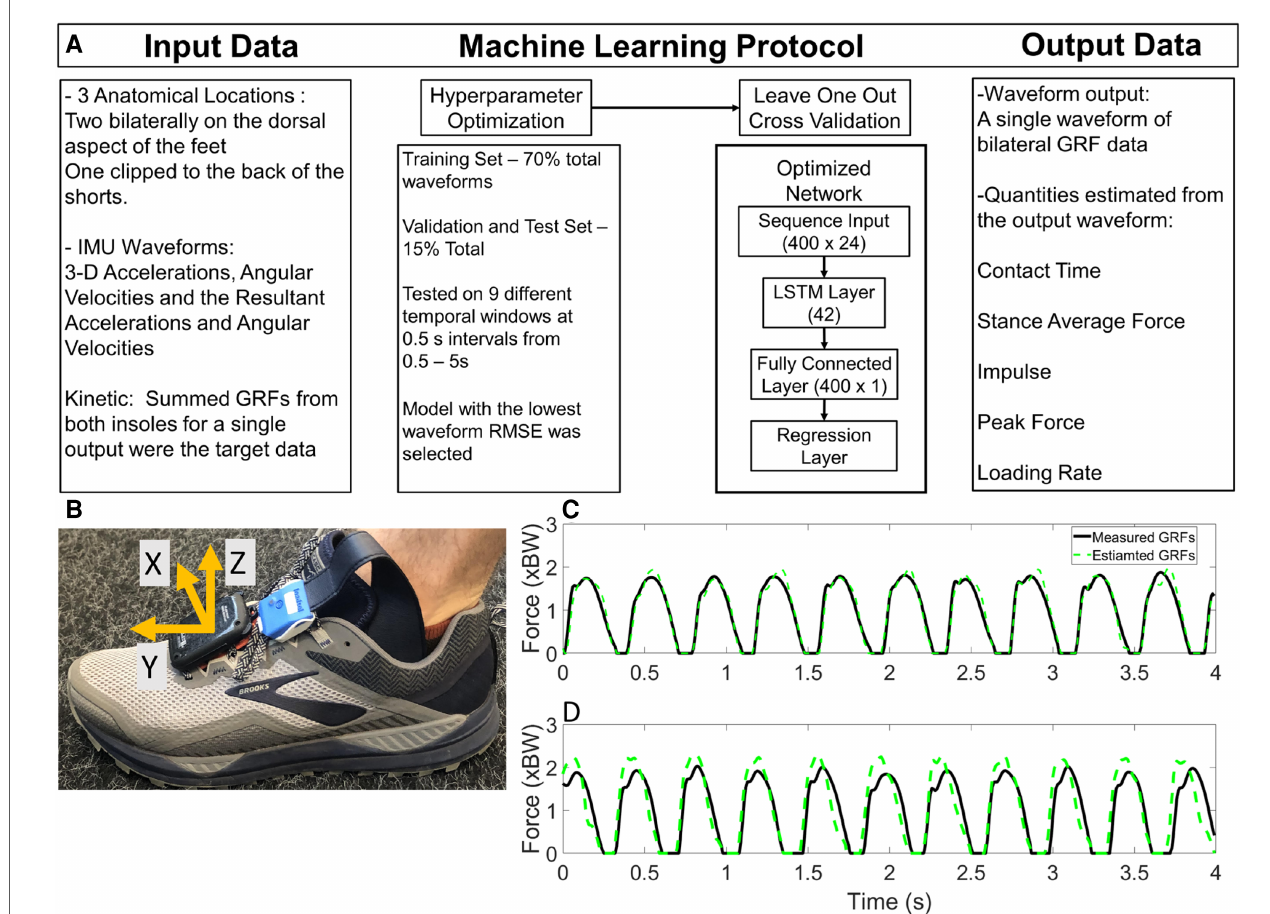
FIGURE 1 Panel A , machine learning methodology and throughput, speci fi cally the input data, machine learning protocol and output. Calculated output contact time and kinetic variables are shown here. Panel B instrumentation on the foot, with the Kalman corrected coordinate system on the IMU. The Sacral IMU was positioned with the orange clip to the posterior of the participant, so the IMU proper was between the participants skin and the shorts to minimize the movement of the sensor. Panel C measured and estimated ground reaction forces from a participant with the smallest RMSE for a participant, Panel D shows the largest RMSE measured and estimated ground reaction forces from the same